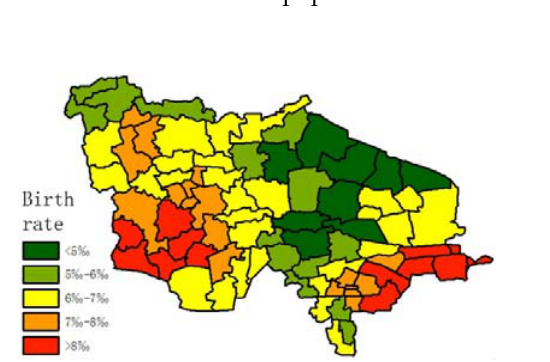
Figure 11. Average migration rate of each town from 2011 to 2015.